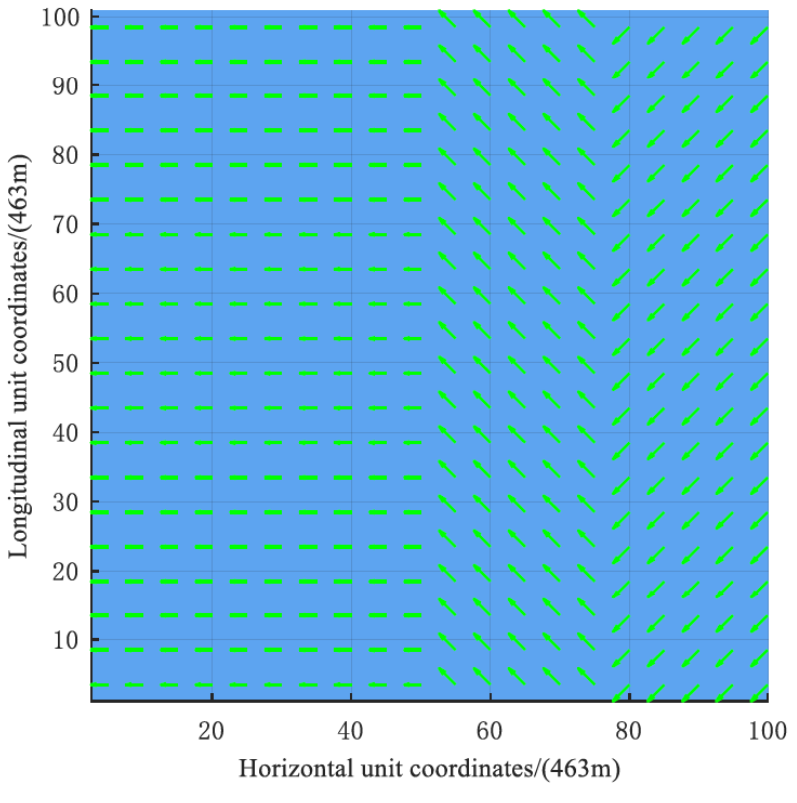
Figure 10. Artificial wind field at the time τ 2 .